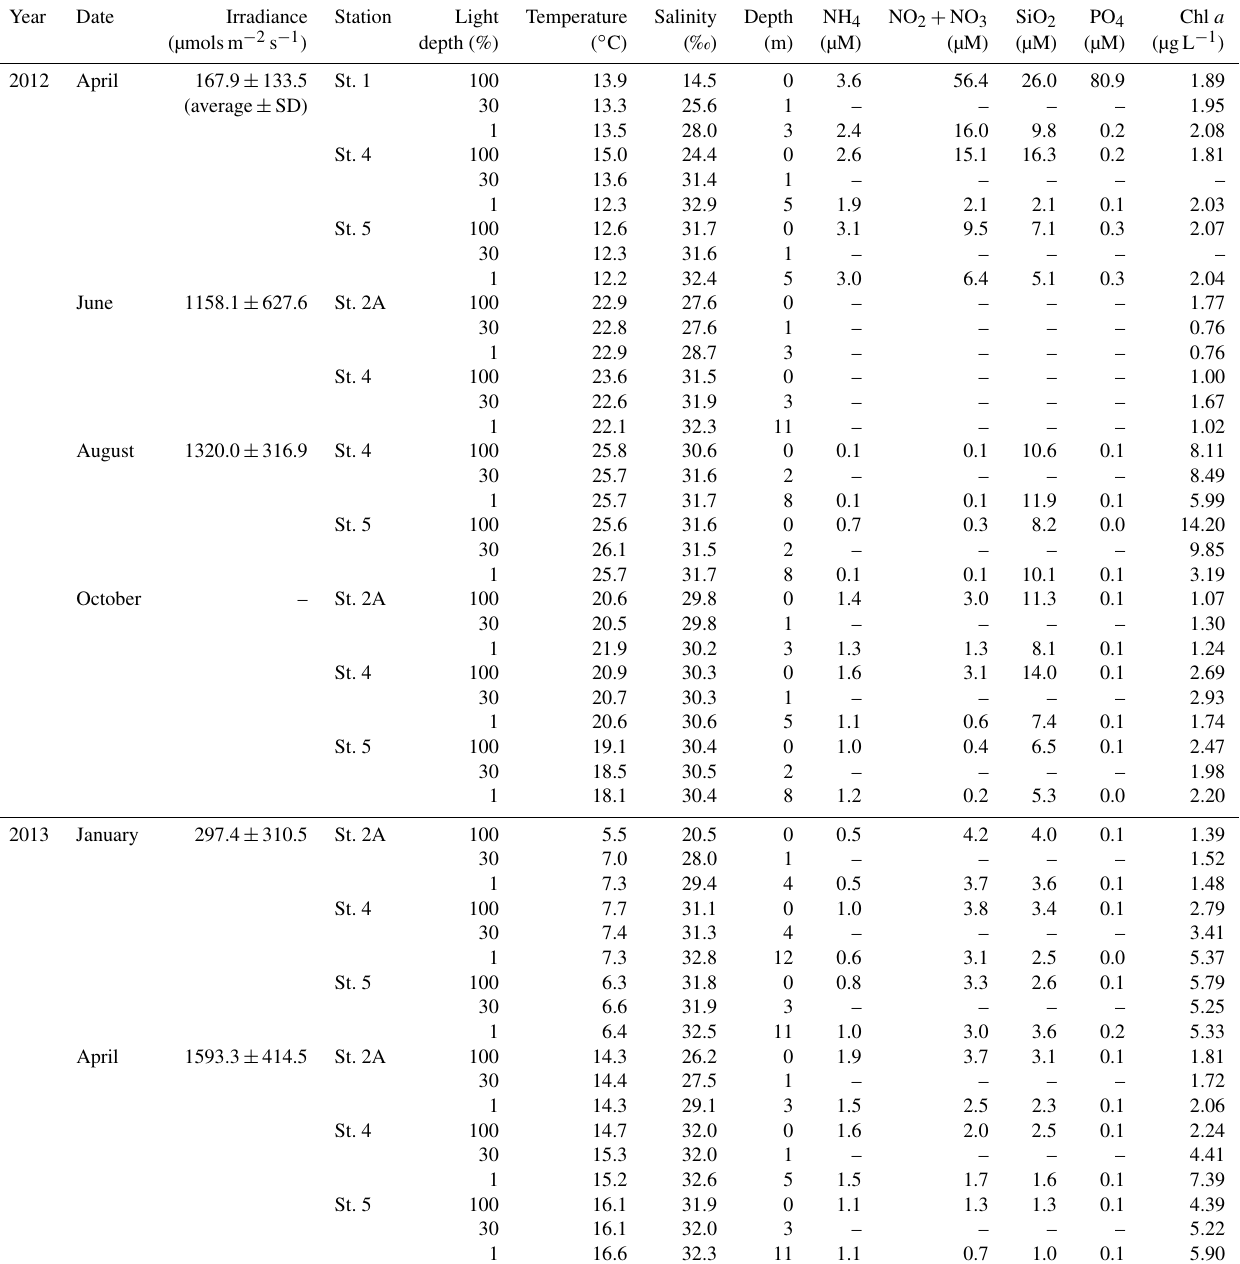
Table 1. The environmental factors and Chl a concentrations in Gwangyang Bay during the research period (“–” indicates no data). Year